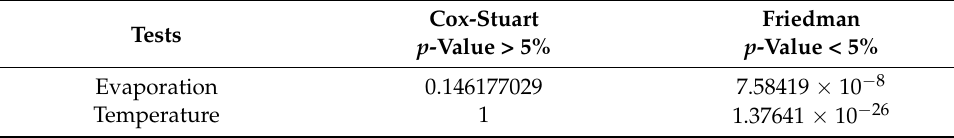
Figure 8. Evaporation and average temperature data for the State of Paran á for the period from January 2004 to June 2019, after passing through the deseasonalization process. Table 16. Non-parametric tests for trend and seasonality